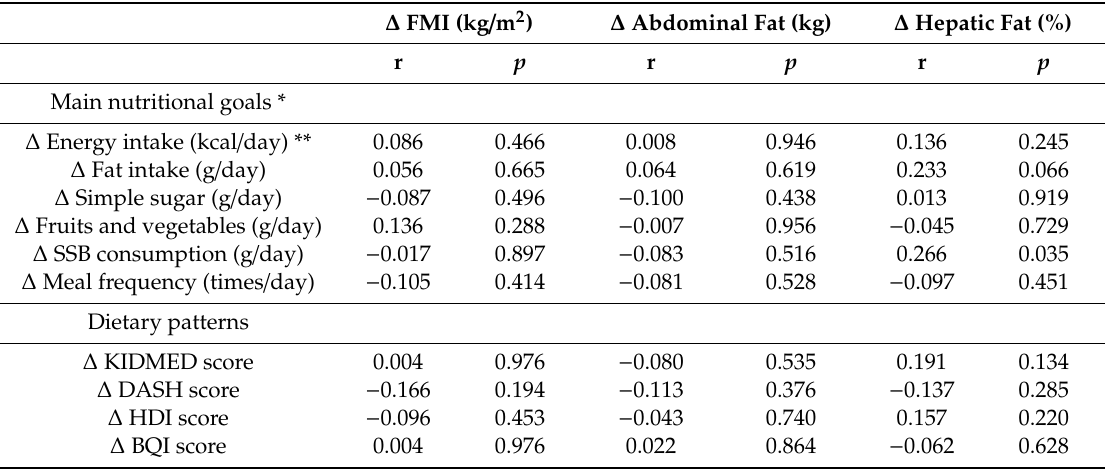
Table 3. Associations of changes in dietary intake with changes in percentage hepatic fat and adiposity markers among children with overweight / obesity. ∆ FMI (kg / m 2